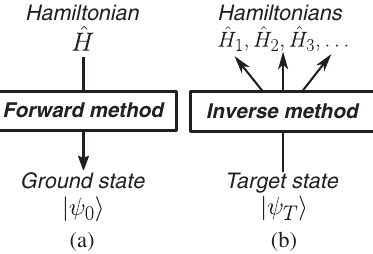
FIG. 1. (a)A typical forwardmethodusedinquantummechanics finds the ground state j ψ 0 i of a single Hamiltonian introduce a new inverse method, EHC, that finds Hamiltonian(s) ˆ H ; ˆ H ; … from a target state j ψ 1 2 energy eigenstate of these